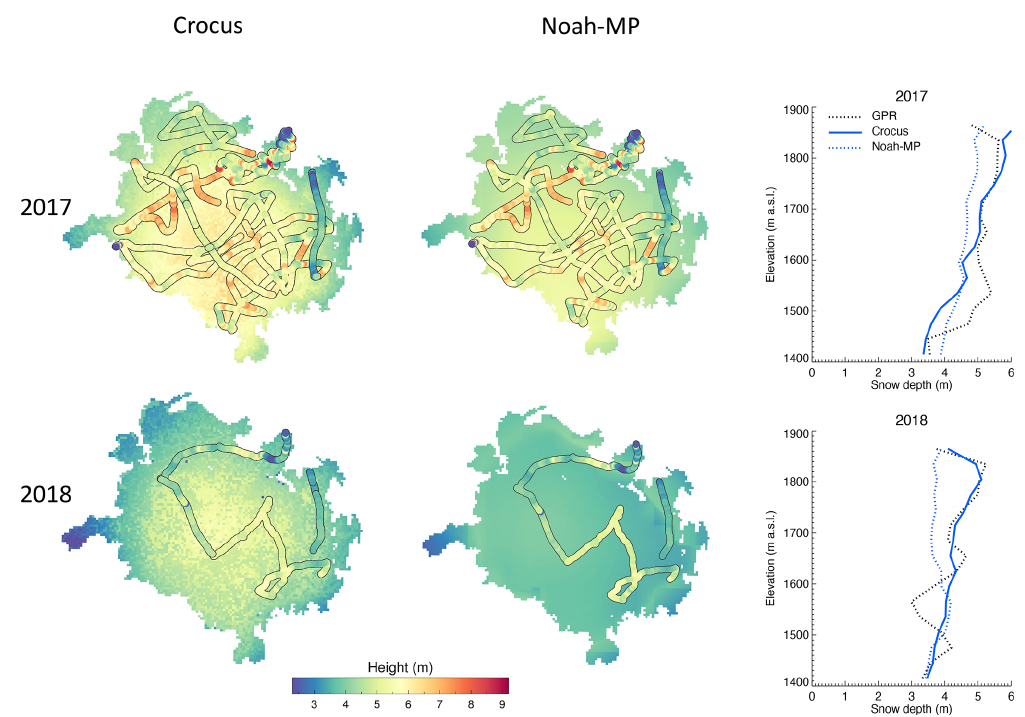
Figure 11. Modeled and observed snow accumulation in April. Observations are with ground-penetrating radar. The left plots are the simu- lation results with Crocus, and the middle plots are simulation results with Noah-MP. The rightmost plot shows the snow depth as a function of